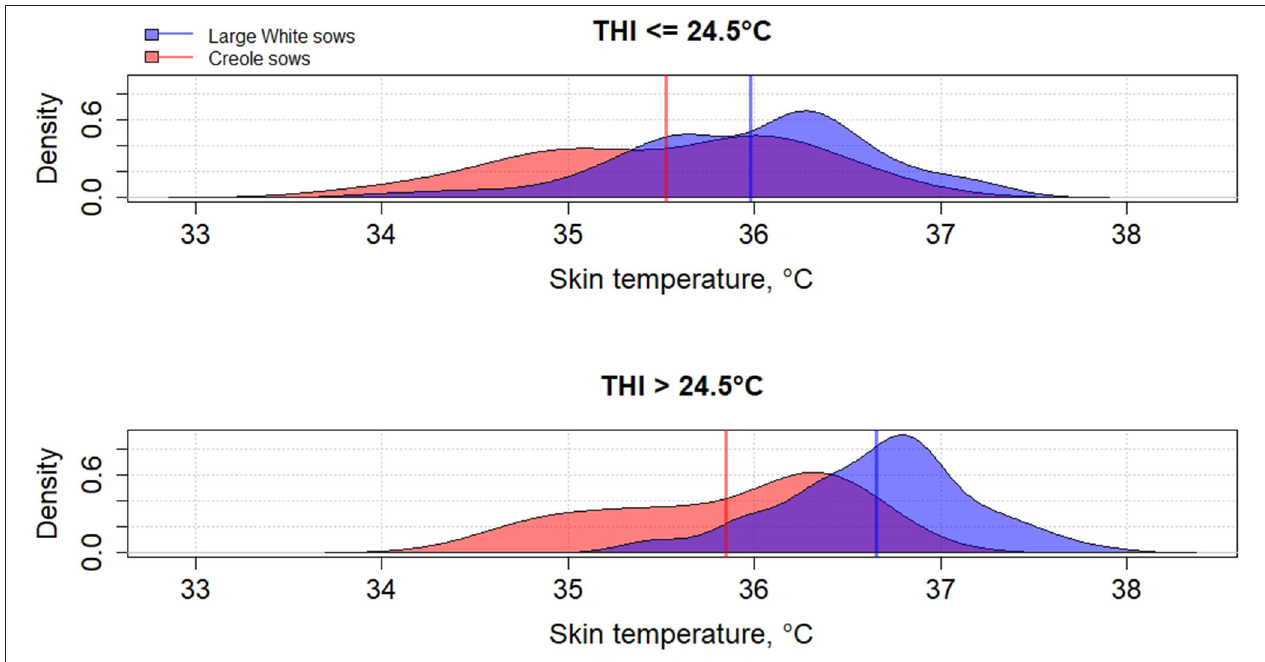
FIGURE 3 | Density distribution of average skin temperature of Creole and Large White lactating sows according to the average thermal-humidity index (THI) during lactation [adapted from Gourdine et al. ( 59)].